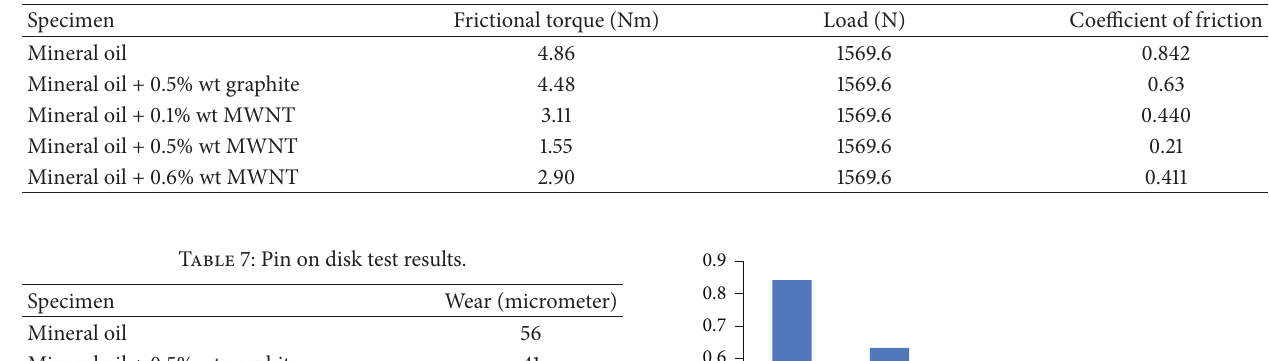
Table 6: Coefficient of friction for different samples.